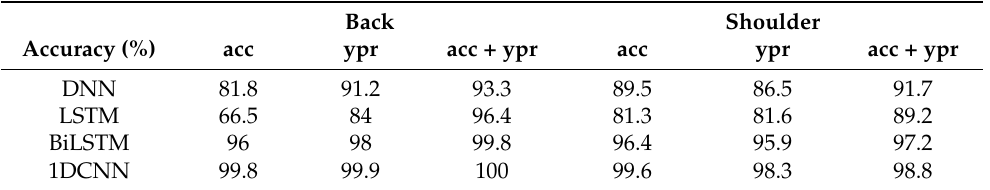
Table 3. Main Result of four networks for the back sensor and shoulder sensor separately. Further- more, acc represents accelerometer data, ypr represents gyroscope data, and acc + ypr represents the combination of accelerometer and gyroscope data.